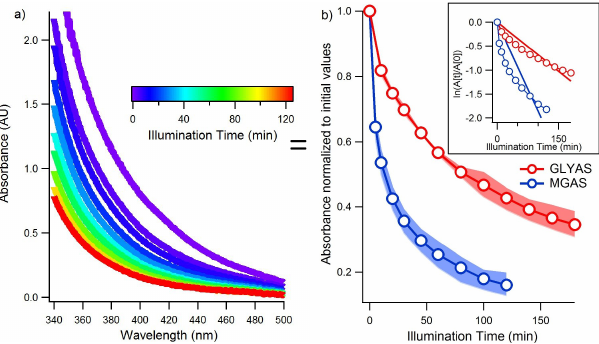
Figure 3. Spectral change of the MGAS solution during a direct photolysis experiment (a) and the absorbance change at 400nm as a function of illumination time (b) . The inset in (b) shows the first- order plot of the decay, and the lines are linear least square plots forced through the origin. The shaded areas represent the range ob- tained from three